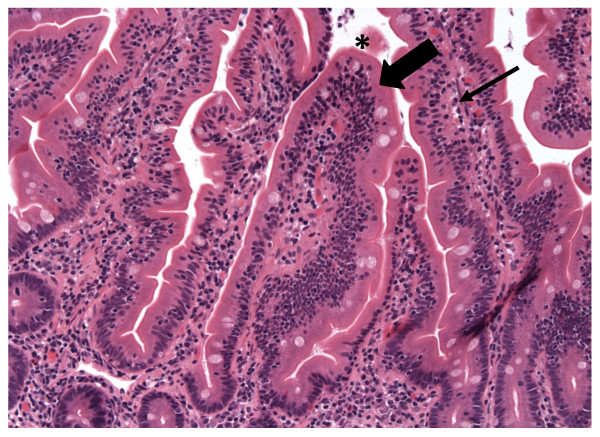
Duodenal biopsy 4 weeks after completing steroid therapy obtained during symptom resolution demonstrating normal tissue (IEL and LP compartments marked by large and small arrows, respectively).